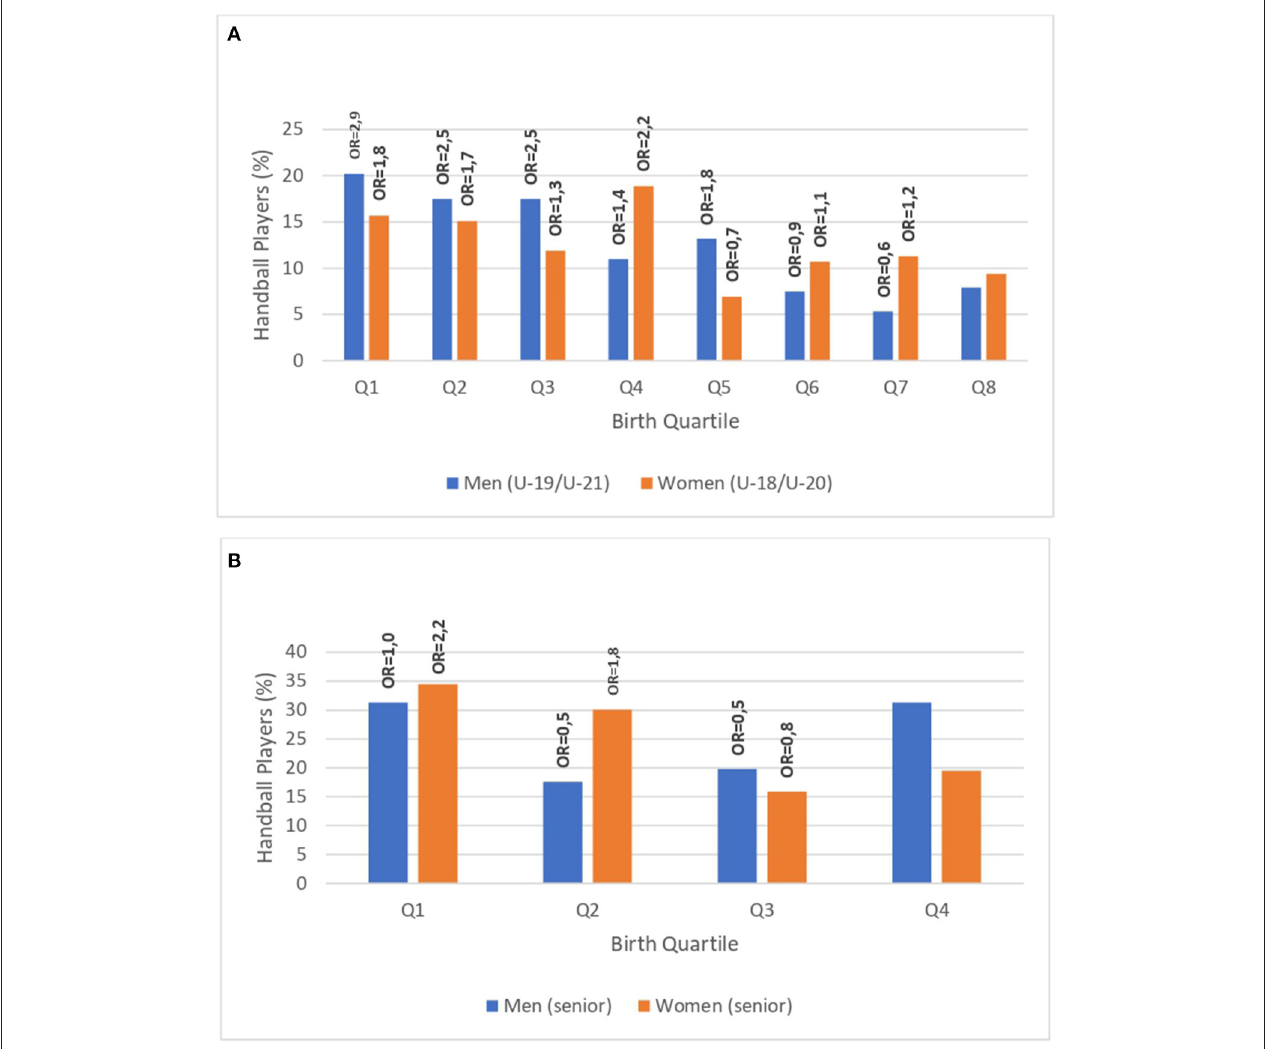
FIGURE 1 | (A) Quarterly distribution (% and OR) of birth dates by gender in formative categories. (B) Quarterly distribution (% and OR) of birth dates by gender in senior category.